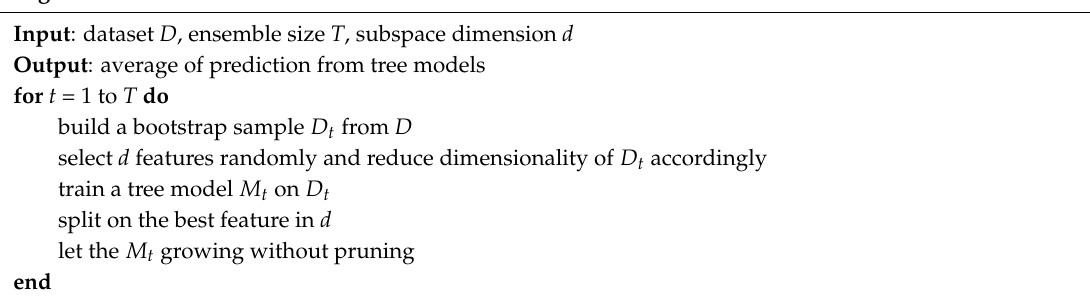
Algorithm 2. Pseudocode for Random